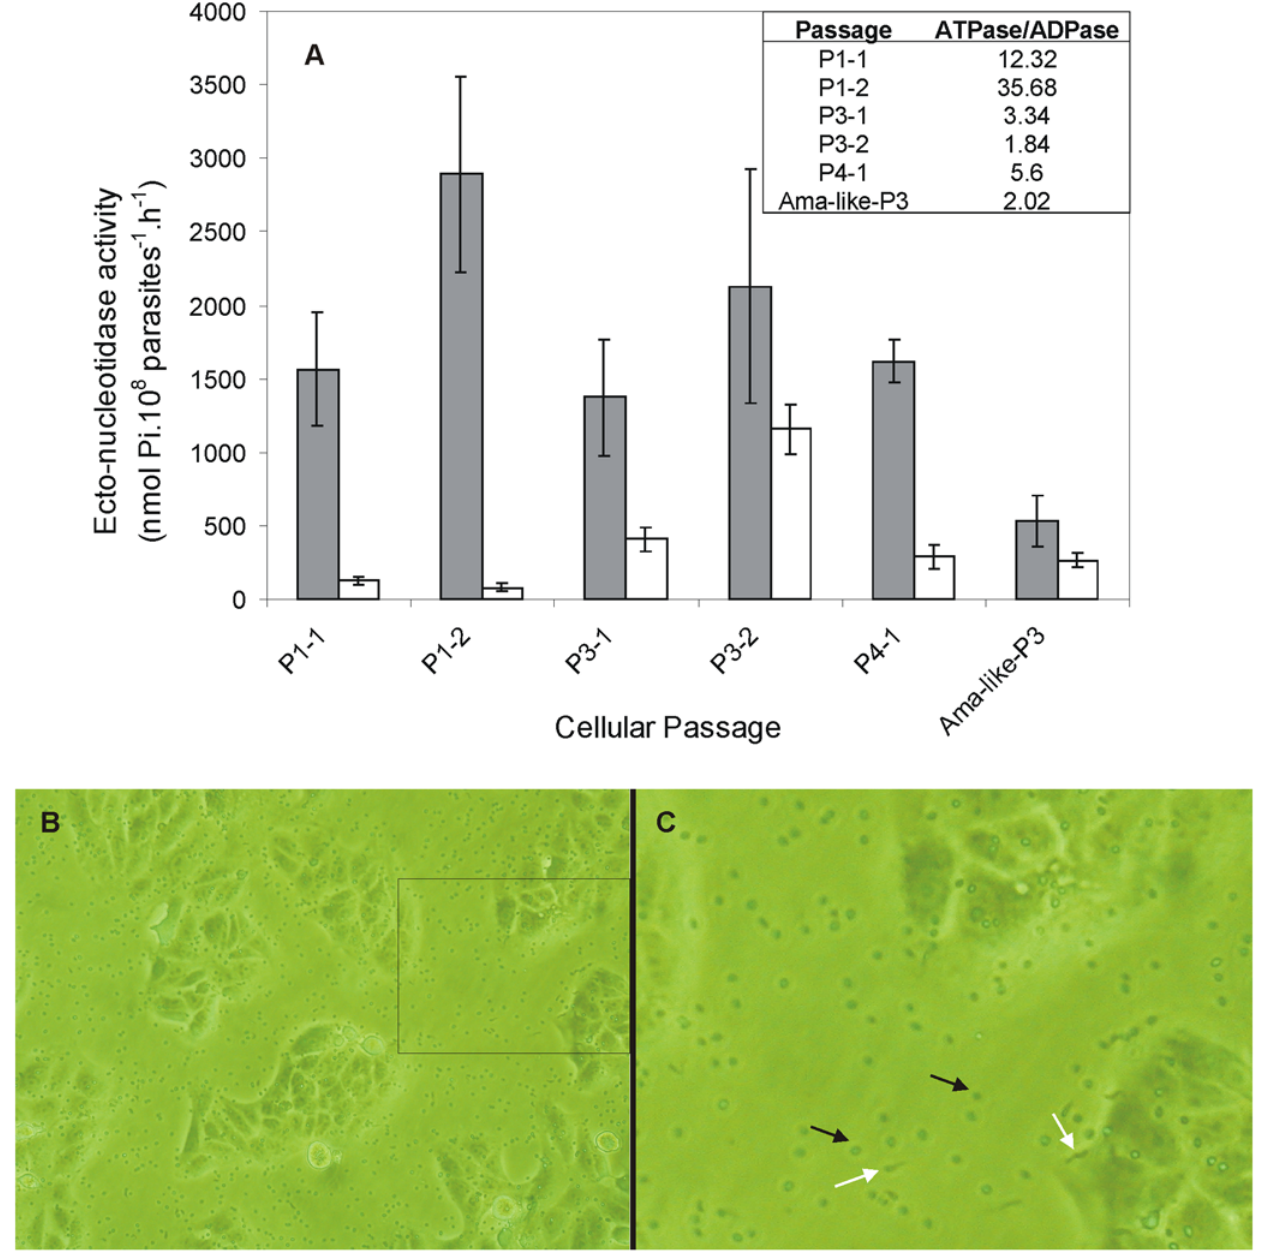
Figure 2. T.cruzi infectivity and ecto-ATPase/ADPase ratio decrease during in vitro cultivation. A) Ecto-ATPDase (solid bars) and Ecto- ADPDase (open bars) activities from live trypomastigotes from different cellular passages (P1, P3 and P4). P1-1 and P1-2 are the first and second massive exits of parasites from the 1 st passage; in the same way P3-1 and P3-2 are the first and second massive exits of parasites for the 3 rd passage. Data are mean 6 SE of triplicate assays from one experiment. The inset shows the ATPase/ADPase hydrolytic activities ratio. B) Microphotograph of infected VERO cells culture after 24 h of parasite-cell interaction at the 3 rd to 4 th passage. Spherical bodies are non-internalized amastigote-like parasites. C) Zoom from box section shown in B. Black arrow exemplifies a non-internalized amastigote-like and white arrow a non-internalized trypomastigote parasite.